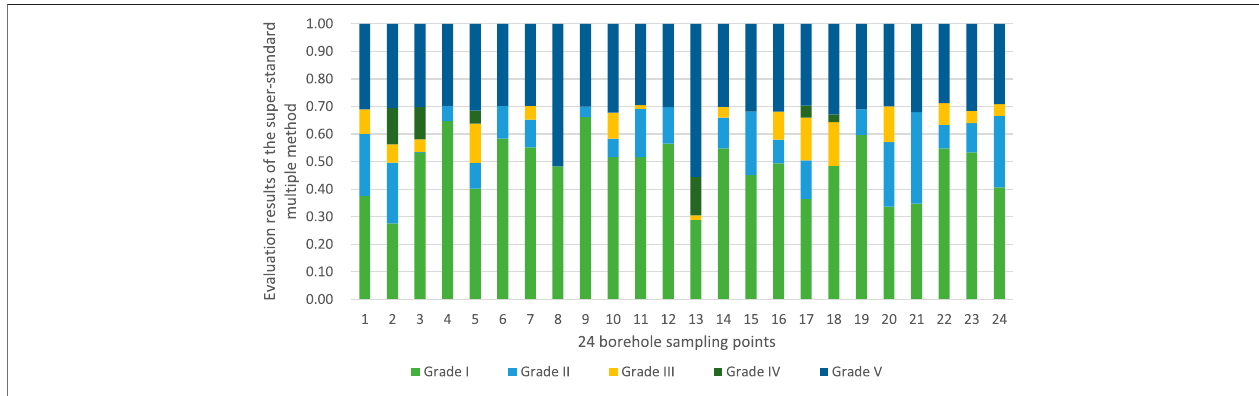
FIGURE 8 | The evaluation results of the super-standard multiple method.